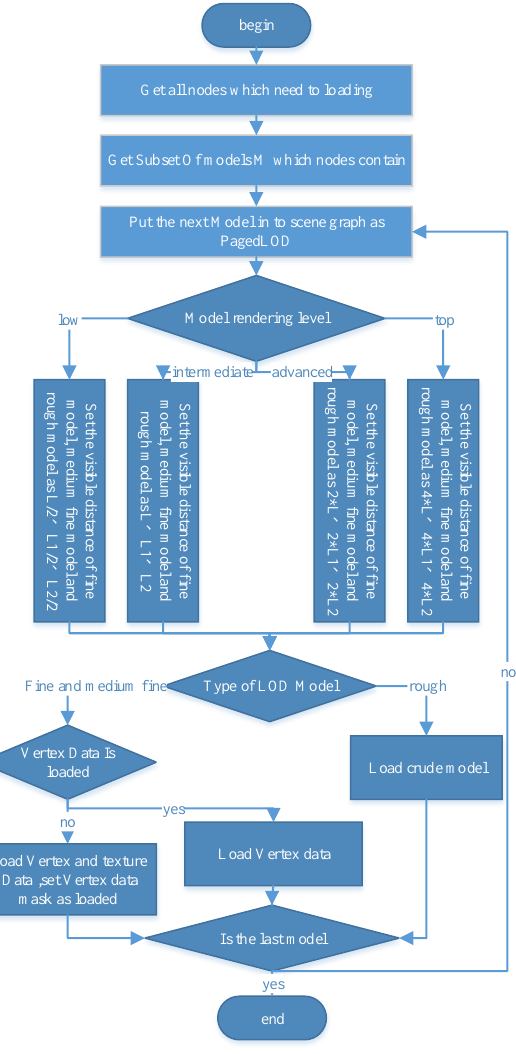
Figure 5. the process of scheduling for Urban 3D model based on weight 2)Korla data volume is large, the data covers an area of 300 square kilometers, Korla area is divided into two parts: the old city and the planning area, texture data more than 400GB,there are more than 800,000 urban 3D model data, contains more than 60000 fine models.